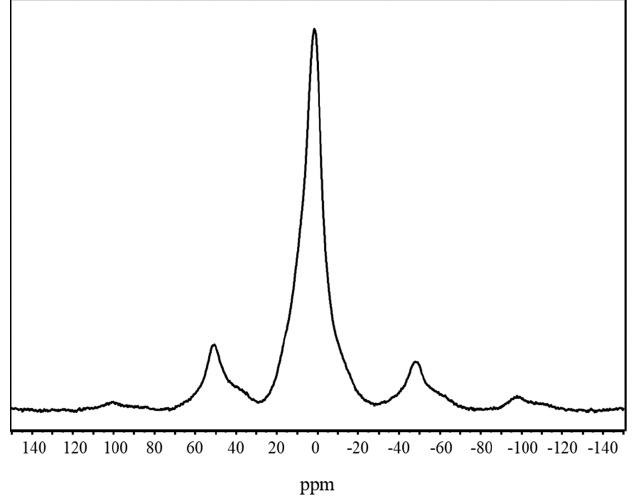
Figure A4. Solid-state 31 P MAS NMR spectrum of HPCP.